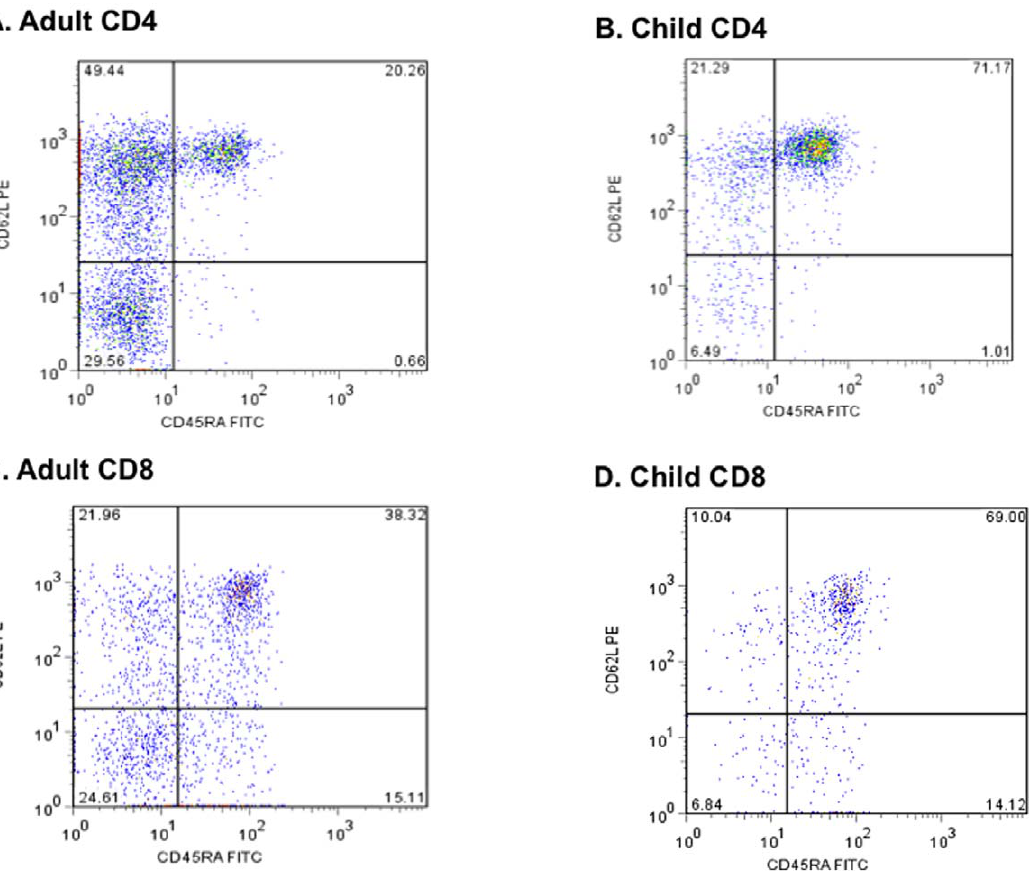
Figure 2. Representative dot plots showing the proportions of CD4 and CD8 T cells subsets defined by CD45RA and CD62L surface expression in adults and children. Dot plot ( A ) Adult CD4, ( B ) Child CD4, ( C ) Adult CD8, ( D ) Child CD8 T cell subsets.